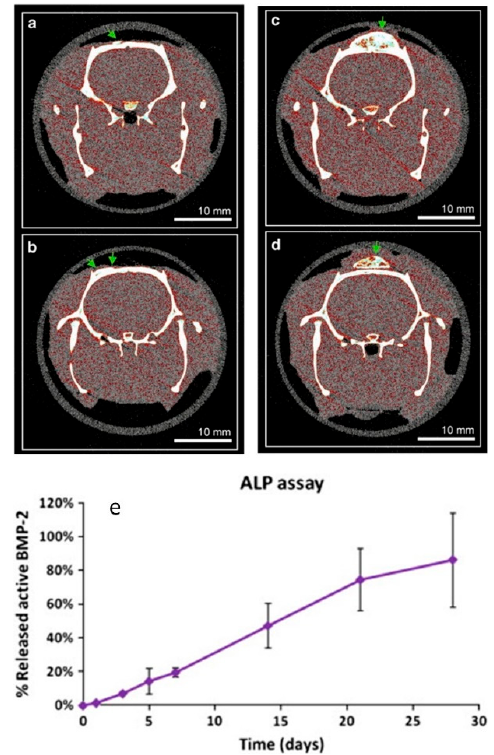
Figure 7 . Representative quantitative computerized tomography (pQCT) coronal section images of injected hydrogel (200 μ L) after 8 weeks. ( a ) subperiosteal injection without rhBMP-2; ( b ) subperiosteal injection with 5 μ g/mL rhBMP-2; ( c ) subperiosteal injection with 150 μ g/mL rhBMP-2; and ( d ) subcutaneous injection with 150 μ g/mL rhBMP-2. Arrows indicate the location of a newly formed bone. ( e ) Controlled release profile of active rhBMP-2 from HA gels up to 28 days of incubation in vitro. From [60]